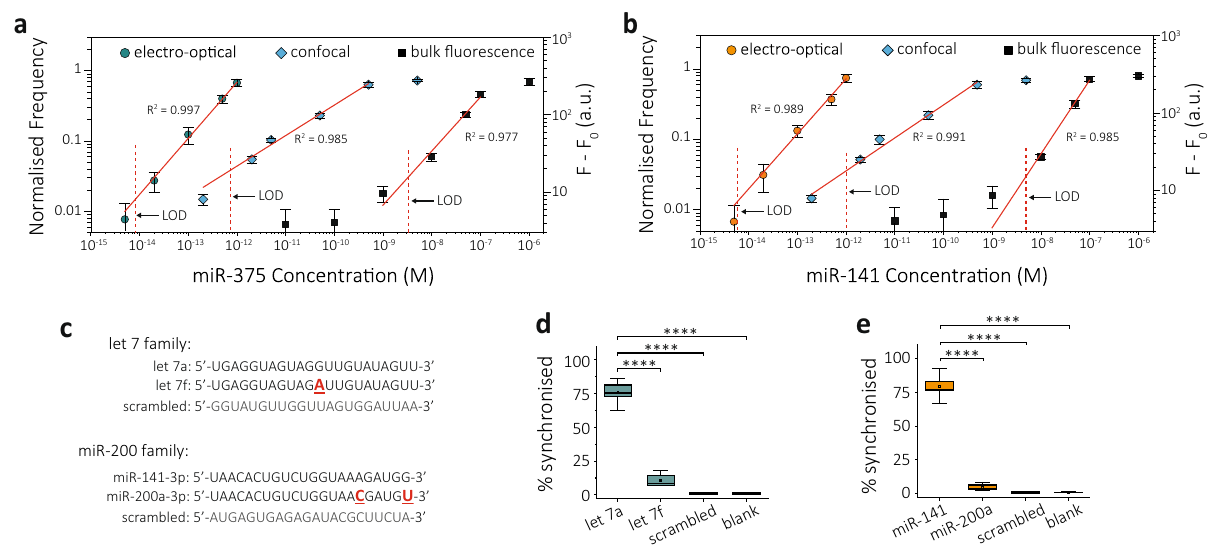
Fig. 4 Sensitivity and selectivity of the detection platforms. a , b Calibration curves for miR-375-3p ( a ) and miR-141-3p ( b ) using asymmetric salt buffer ( cis , 40 mM KCl; trans , 400 mM KCl). The concentrations of both molecular probes are 1 pM. As a comparison, data are shown using conventional single- molecule confocal microscopy and bulk fl uorescence using molecular beacons at a concentration of 500 pM/100 nM. The dashed lines represent LODs at three times the standard deviation (3 σ ) of blank controls. The error bars represent 1 × σ obtained from 3 different nanopore measurements ( n = 3). Data are presented as mean ± s.d. a.u., arbitrary units. c Sequences used for assessing the selectivity, consisting of the perfectly matched targets (let-7a, miR- 141-3p), single-/double-nucleotide mutants (let-7f, miR-200a-3p), and scrambled sequences to Probe-let-7a and Probe-141. Variant bases are highlighted in red. d , e Box plots summarising the % synchronisation with these sequences. The black central line represents the median, the bottom and top edges mark the 25th and 75th percentiles, and the whiskers represent 1.5× interquartile range (IQR). Statistical signi fi cance was tested using a two-tailed Student ’ s t -test; **** P < 0.0001. All the measurements were performed with at least 3 independent nanopores ( n = 5 for let-7a/miR-141-3p; n = 4 for let- 7f/miR-200a; n = 3 for scrambled sequences; n = 5 for blank